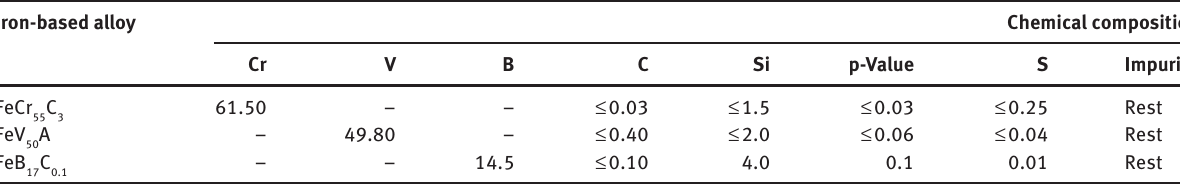
Table 2 The chemical composition of all iron-based alloy powder (wt%).